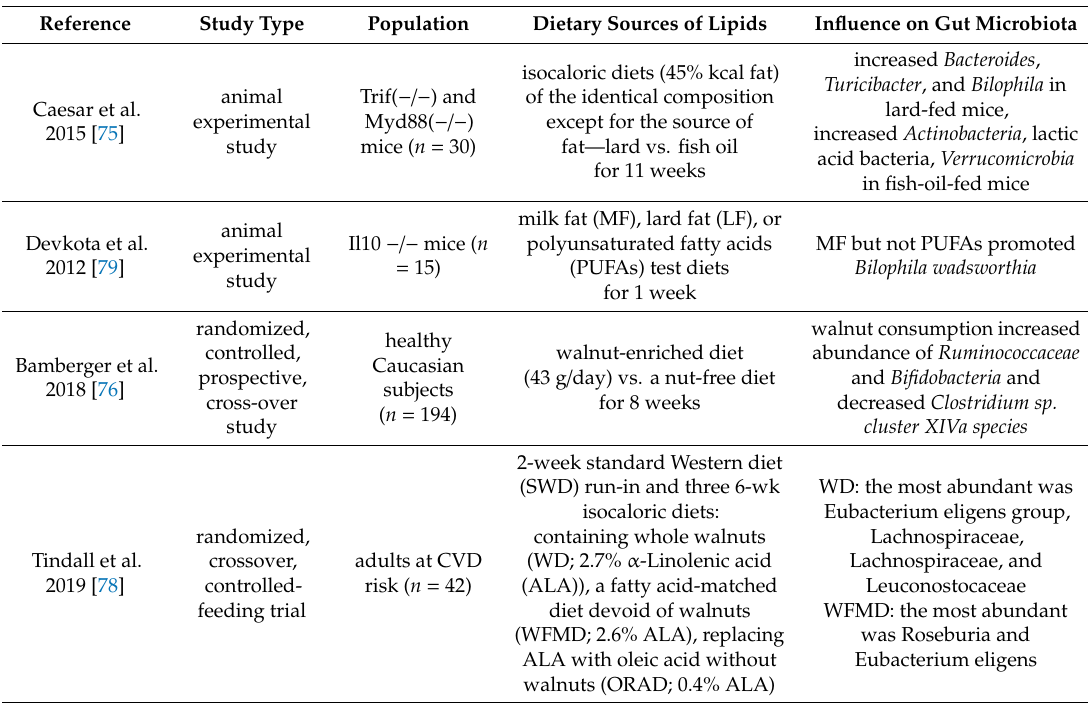
Table 3. Influence of lipids on